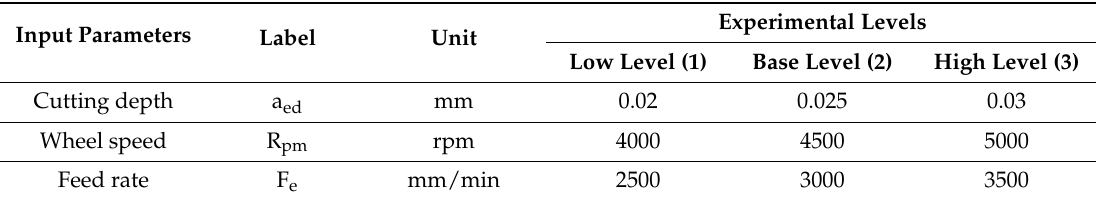
Table 2. Input process parameters and design levels.